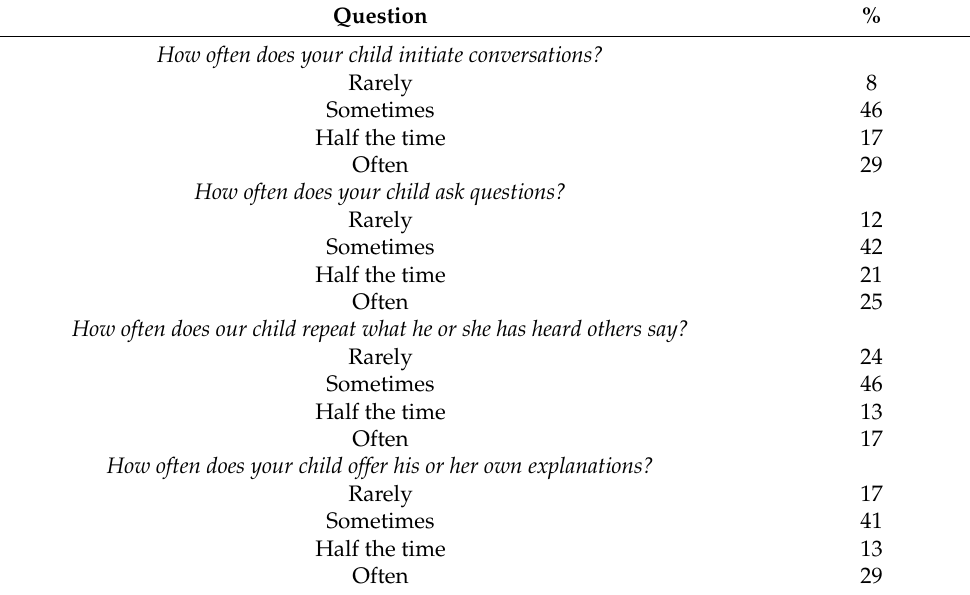
Table 2. Dimensions of parent–child communication about